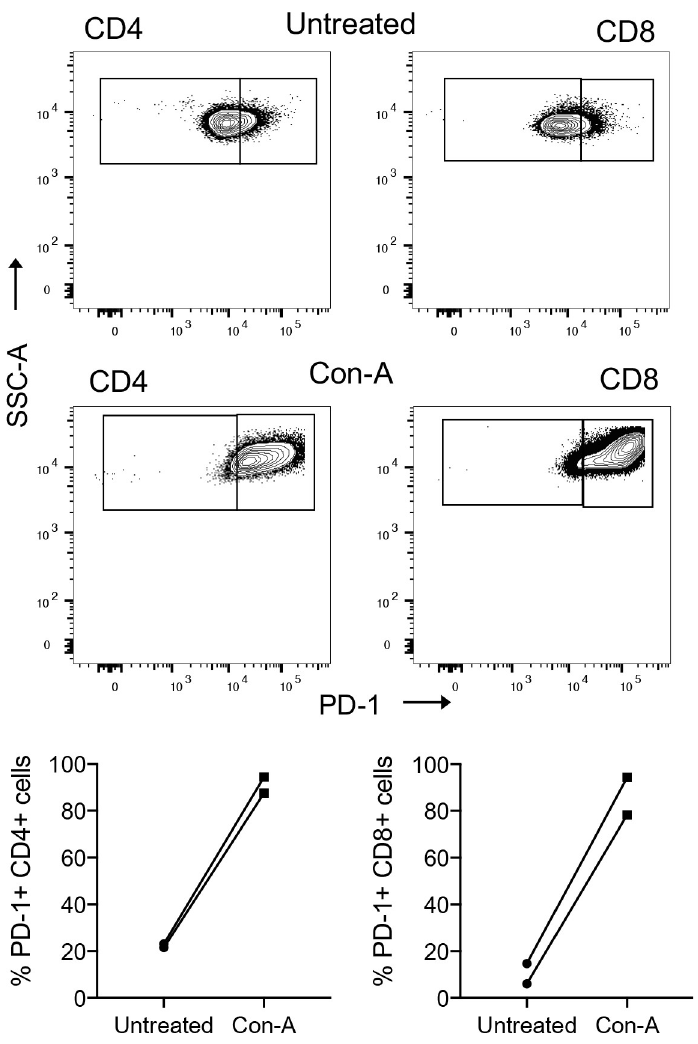
Fig 5. Detection of PD-1 expression on CD4 + and CD8 + T-cells from peripheral blood by anti-canine PD-1 antibody JC053. Representative staining of PBMC T cell subsets for PD-1 expression by flow cytometry using antibody JC053 from a healthy canine donor is shown before and after stimulation with ConA for 24 hours (A). Frequencies of PD-1 expressing CD4 + and CD8 + T-cells before and after stimulation of PBMCs from two healthy canine donors were evaluated by flow cytometry using antibody